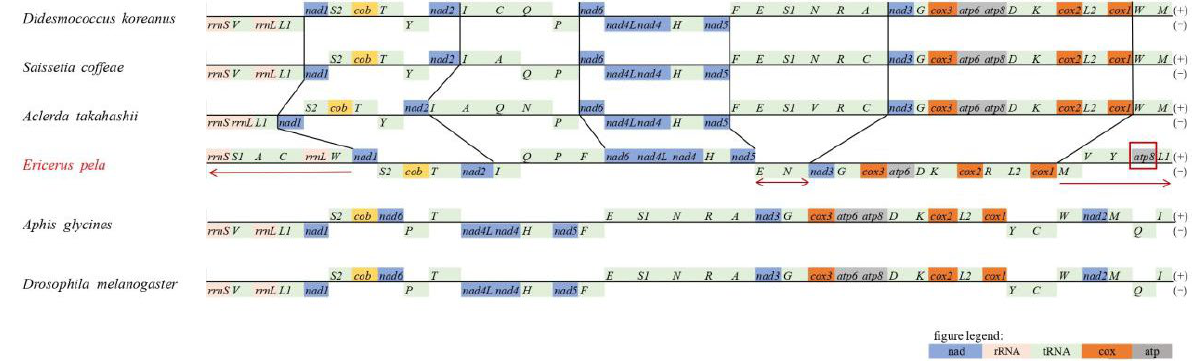
Figure 2. Mitochondrial gene order of 4 scale insects (Coccoidea) , Aphis glycines and Drosophila melanogaster . The genes on the H-strand (+) are shown above the line and the genes on the L-strand ( − ) are shown below the line. The black lines are used to show general conserved gene regions among the 4 Coccoidea species. The red arrows below E. pela represent the most significant distinctions.